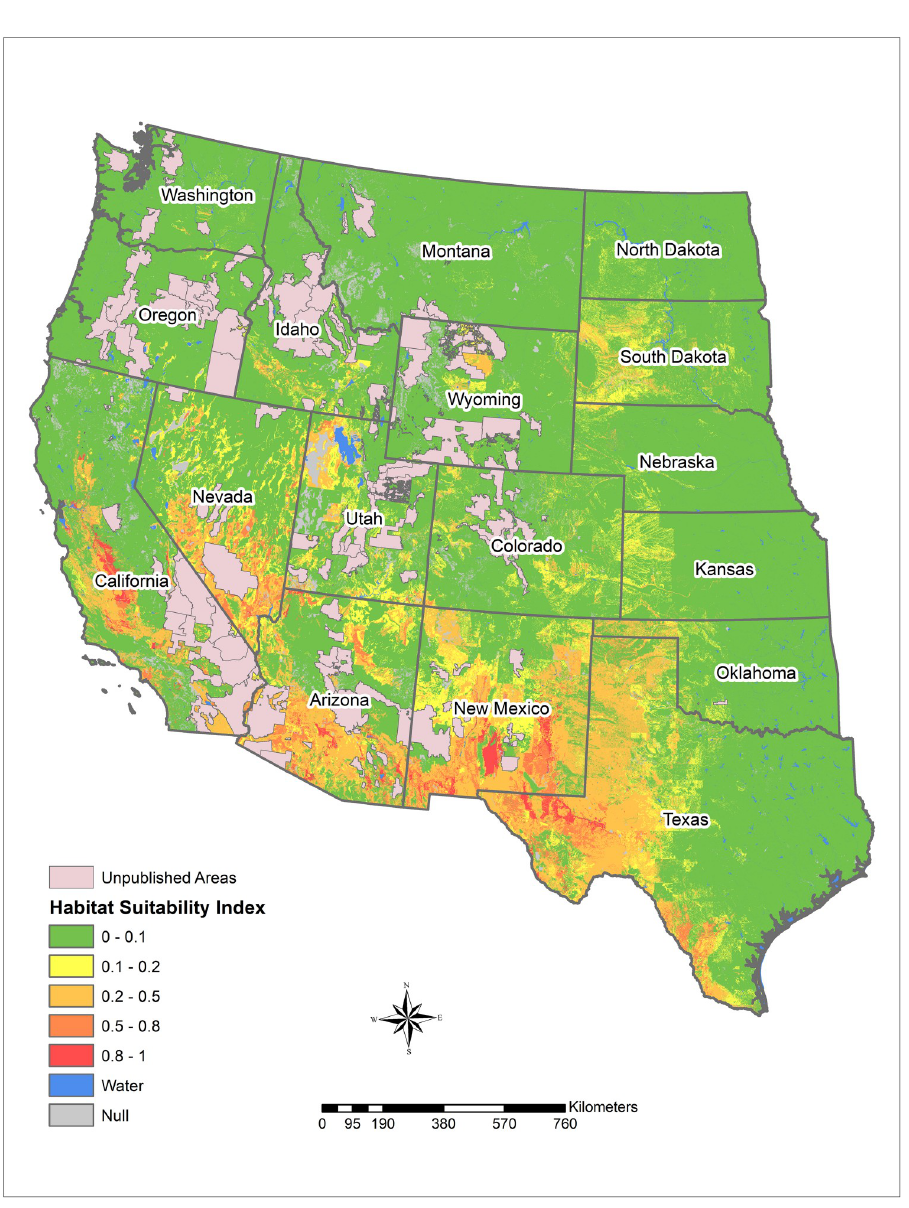
Fig 1. Predicted Coccidioides habitat suitability index for the western United